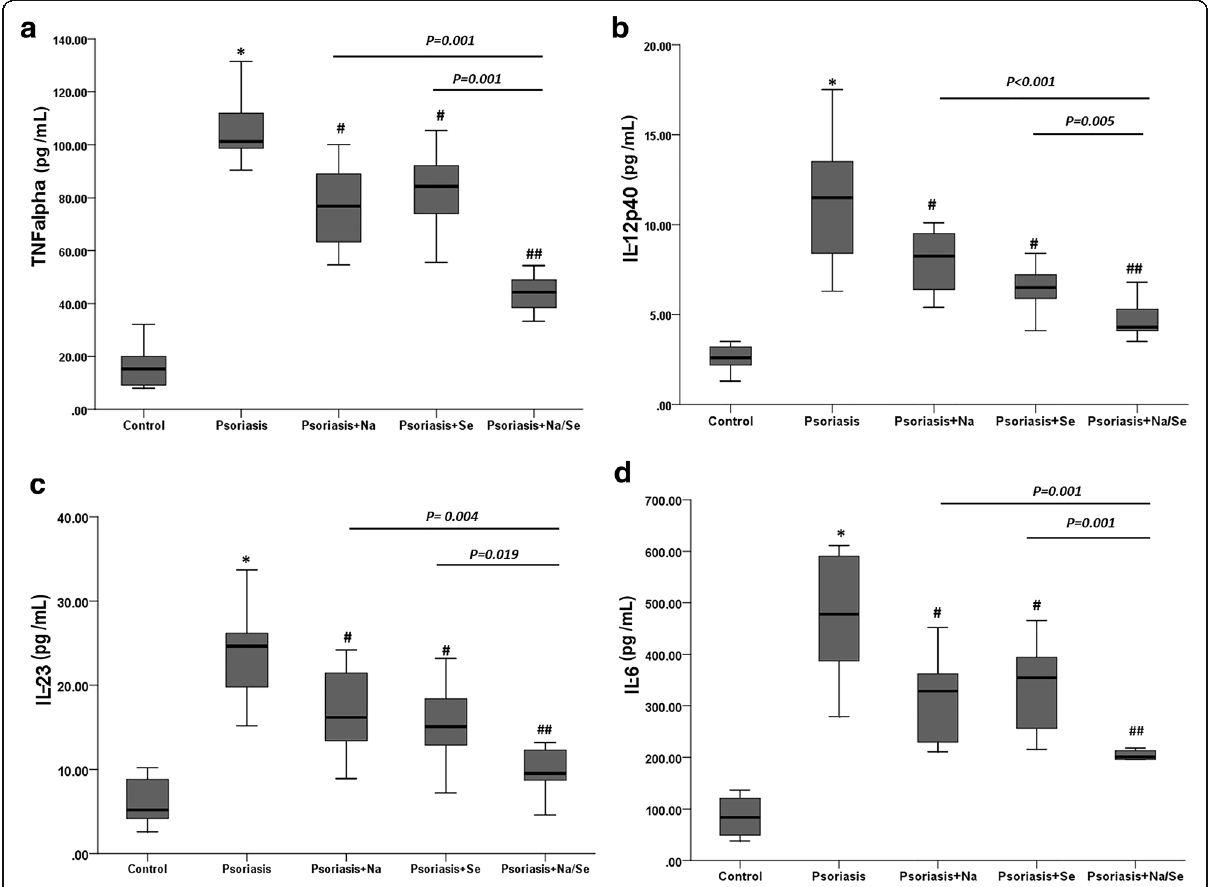
Fig. 4 Effect of naringin (Na) and sericin (Se) on the induction of the production of ( a ) TNF- α , ( b ) IL-12p40, ( c ) IL-23, and ( d ) IL-6. The hPBMCs from healthy subjects (untreated control) and patients with psoriasis were treated with 20 μ g/mL Na, 100 μ g/mL Se and Na/Se combination (20/100 μ g/mL at the ratio of 1:1 (v:v). The cytokine production was measured by ELISA. Data are expressed as median (range) of 10 samples in each group (3 independent experiments, triplicate each). *P < 0.001 vs. untreated control hPBMCs from healthy subjects by Mann-Whitney U test. #P < 0.05 and ## P < 0.001 vs. untreated pPBMCs from psoriasis patients by Mann-Whitney U test. One vs. untreated pPBMCs from psoriasis patients by Mann-Whitney U